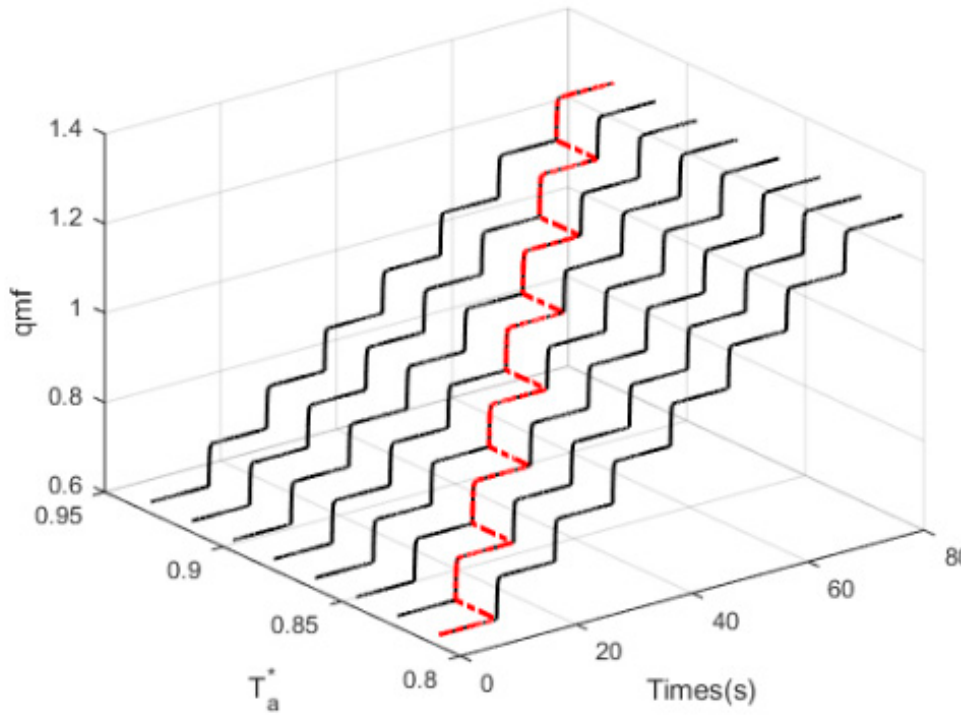
∗ a in the training